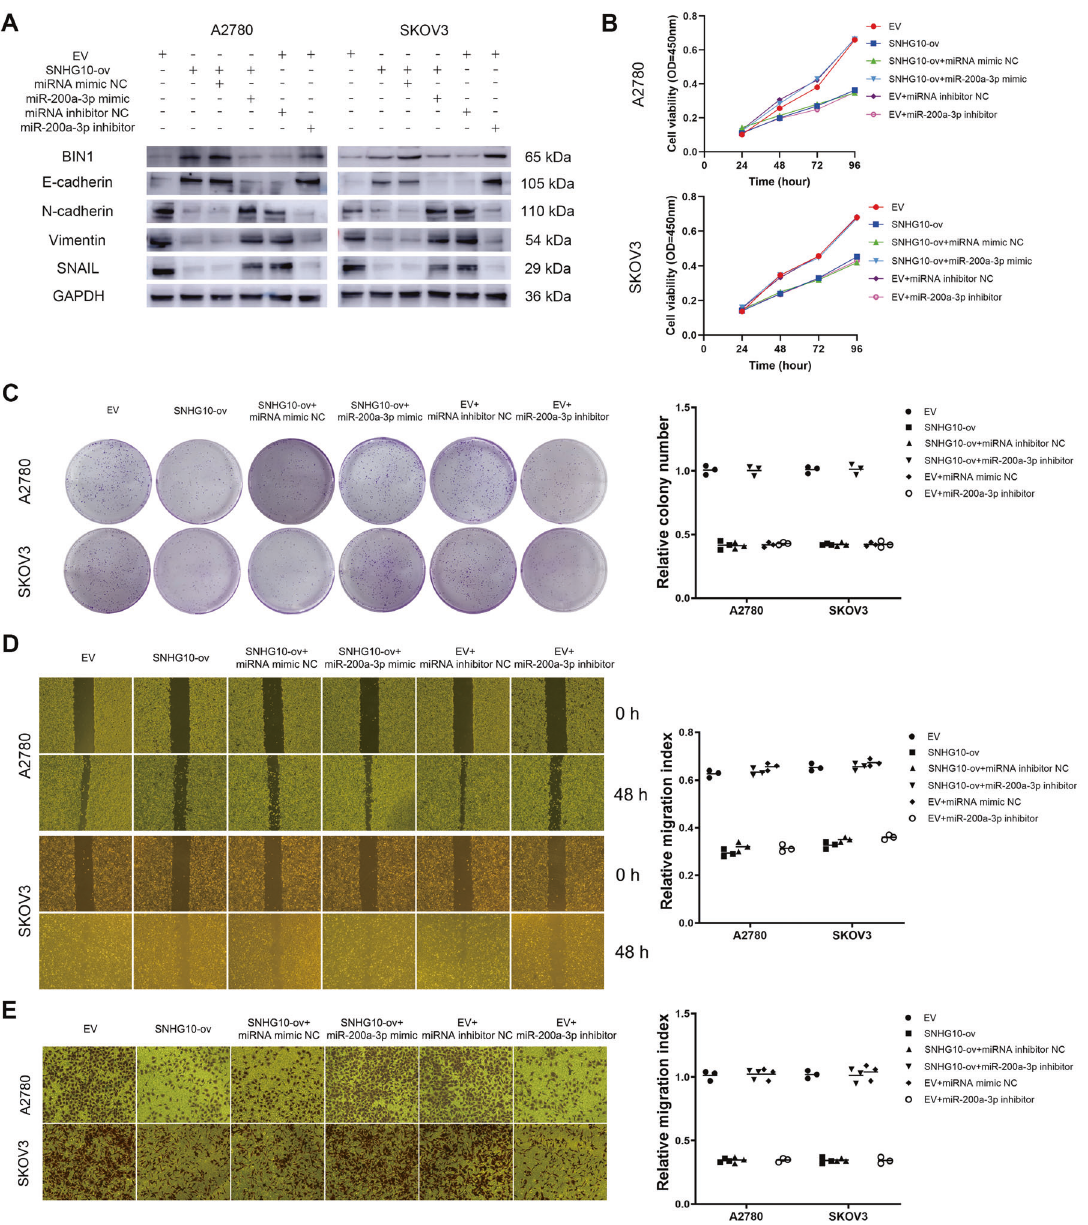
Fig. 6 The effects of SNHG10/miR-200a-3p/BIN1 axis on the malignant behaviors of EOC cells. A The effects of the SNHG10/miR-200a-3p axis on the expressions of BIN1 and EMT-related proteins. B The effects of the SNHG10/miR-200a-3p/BIN1 axis on the proliferation ability in EOC cells. C The effects of the SNHG10/miR-200a-3p/BIN1 axis on the clone formation ability in EOC cells. D The effects of the SNHG10/miR- 200a-3p/BIN1 axis on the migration ability in EOC cells. E The effects of the SNHG10/miR-200a-3p/BIN1 axis on the invasion ability in EOC cells. The experiments were conducted in